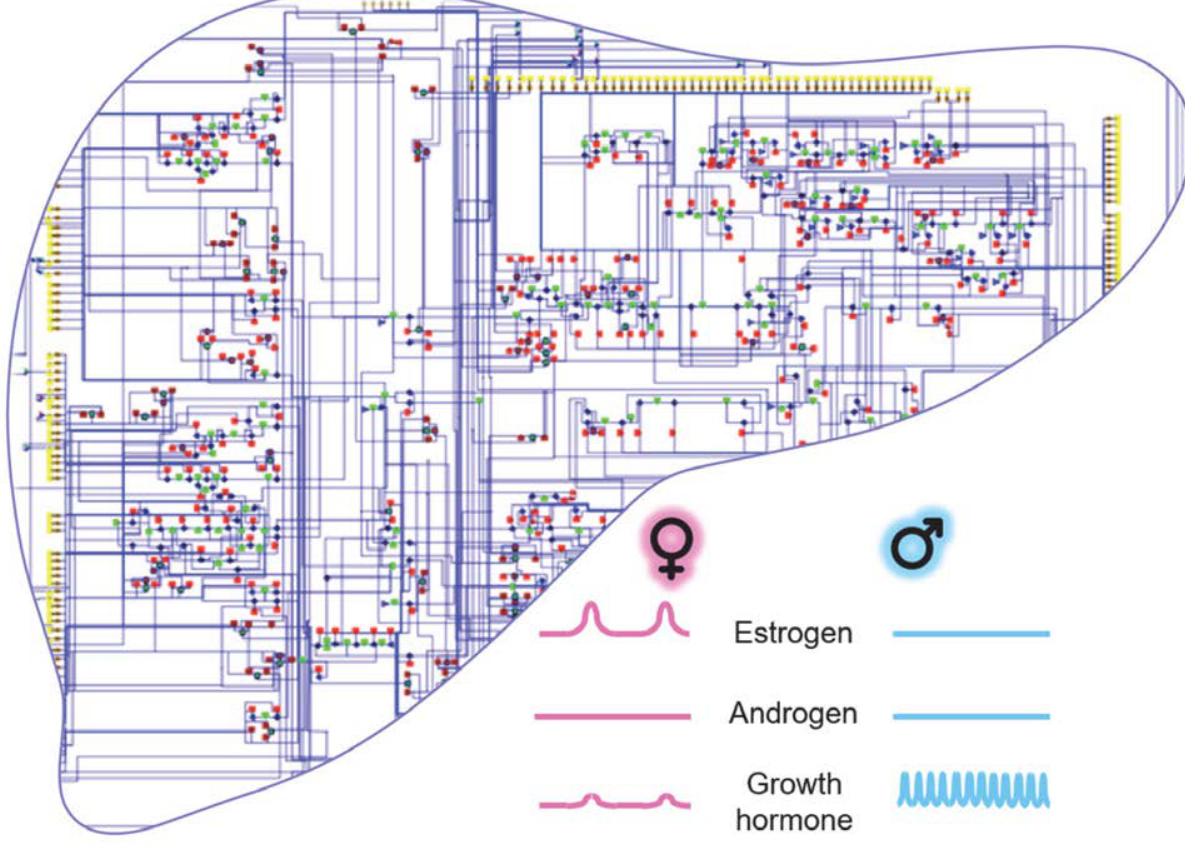
Figure 3: LiverSex presents the gender-based adaptation of the SteatoNet model, and is able to provide detailed insights into gender-dependent complex liver pathologies. The adaptation was performed with the addition of androgen and estrogen receptor responses, the addition of connec- tions between sex steroids and growth hormone, and the addition of gender-based growth hormone release (see 20